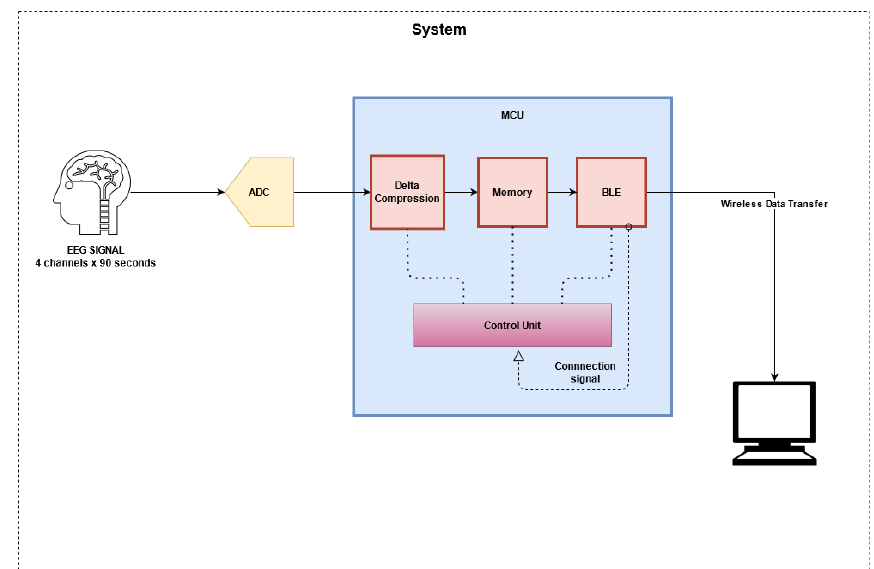
Figure 1. The system modules and interconnection